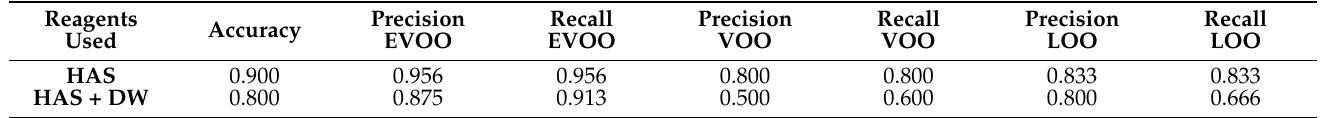
Table 8. Comparison of the classification metrics in the case of three classes classification (EVOO, VOO and